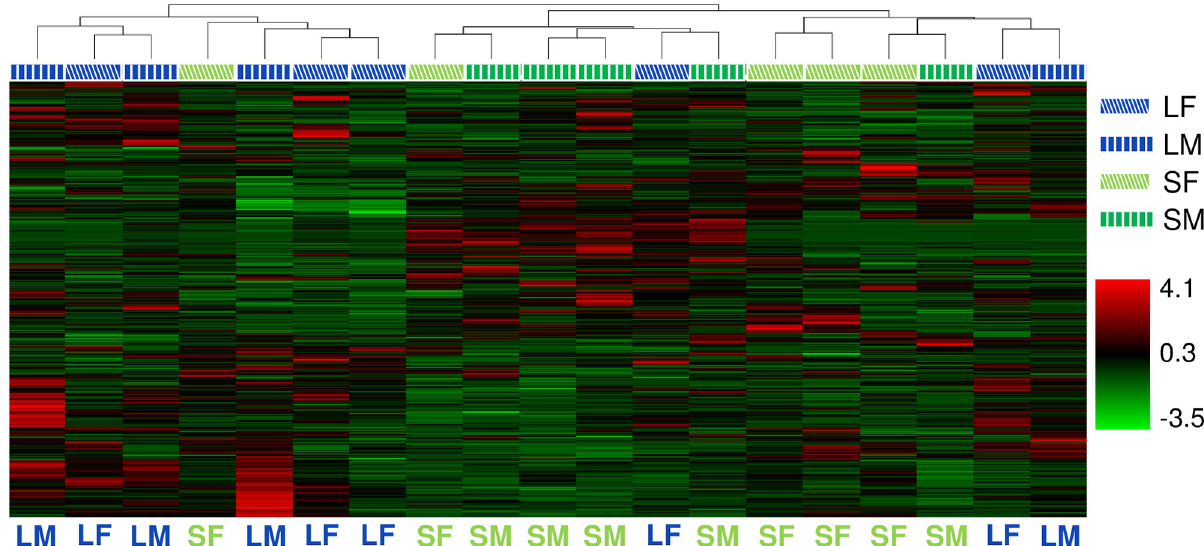
Fig 1. Hierarchical clustering for all samples used in this research. Blue and green represent large and small animals, respectively. Diagonal stripes and vertical stripes represent females and males, respectively. Note that one of large animal samples has been removed due to misplacement during sample preparation (see Methods section).